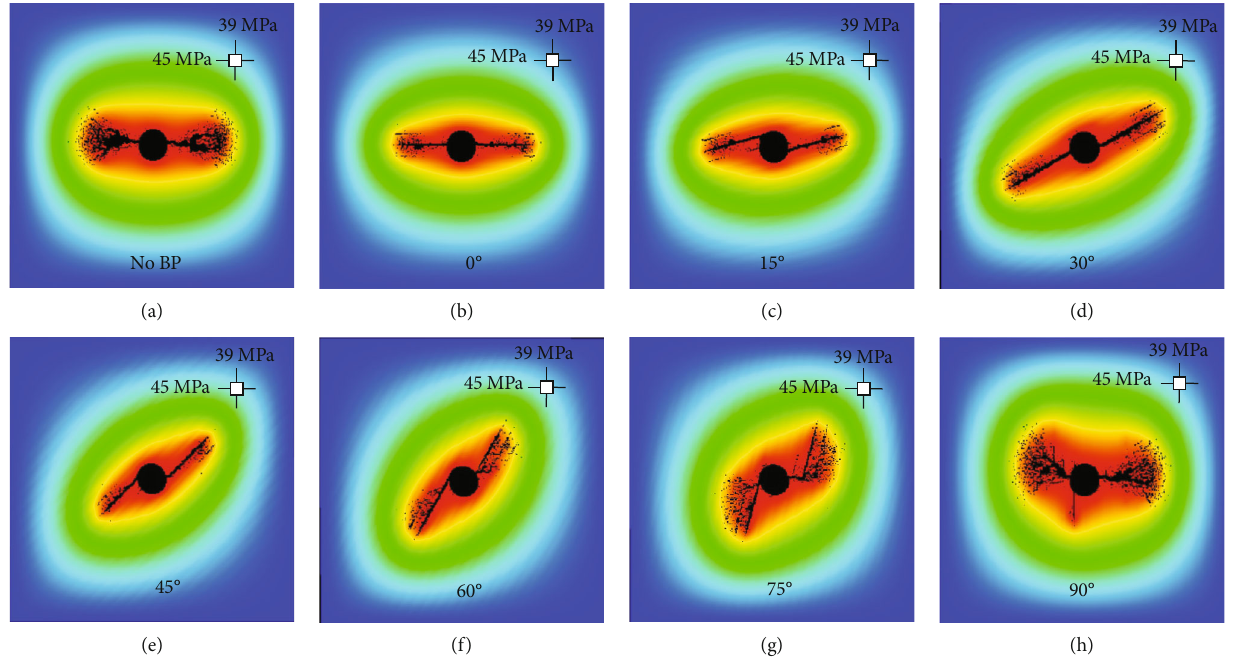
Figure 8: HF morphologies of a large permeability coe ffi cient under di ff erent BP angles with actual in situ stress ( K ′ = K ′ = 0 : 005 K v h